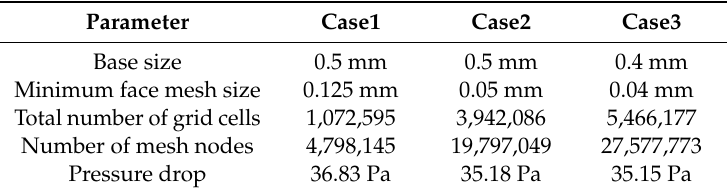
Table 1. Detail parameter values of mesh.